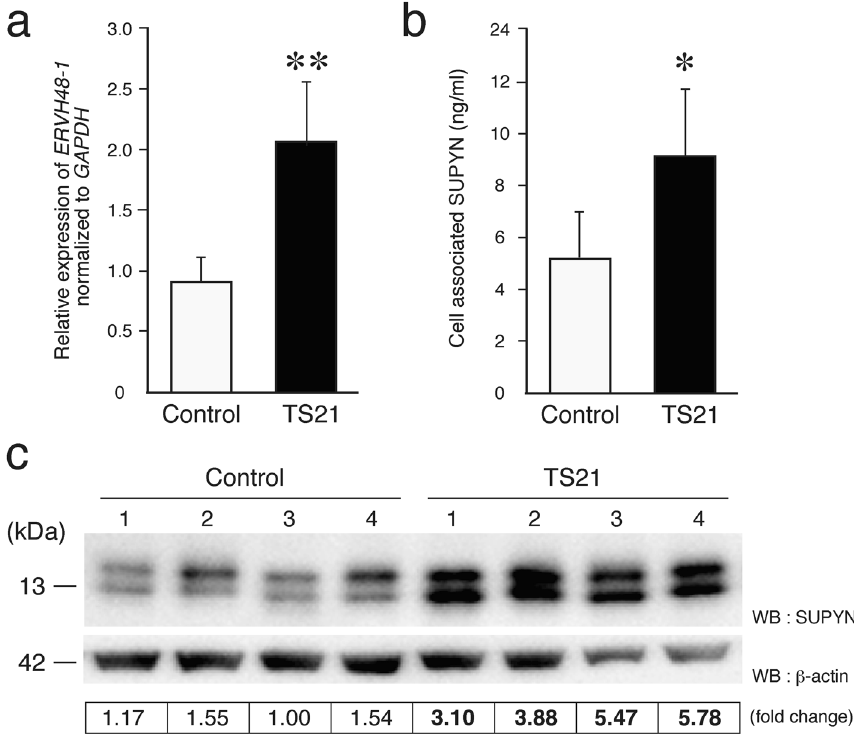
Figure 1. Expression of ERVH48-1 transcripts and SUPYN protein in the TS21 placenta. ( a ) ERVH48-1 gene transcripts in TS21 and gestational age-matched disomic control placental samples using quantitative RT-PCR. ( b ) SUPYN protein (ng/ml) levels in placental cell lysates from TS21 and gestational age-matched controls using a SUPYN-specific ELISA. Statistical analysis was performed using the Mann Whitney U test. Statistical significance was set at * : p < 0.05, ** : p < 0.01. Values represent mean ± SD (n > 5). ( c ) Western blot analyses using a monoclonal antibody against SUPYN. Lanes 1–4: four independent human placental samples from gestational age-matched control placentas ; Lane 5–8: four independent human TS21 placentas. Quantitative SUPYN protein levels were normalized to β-actin and presented in the bottom